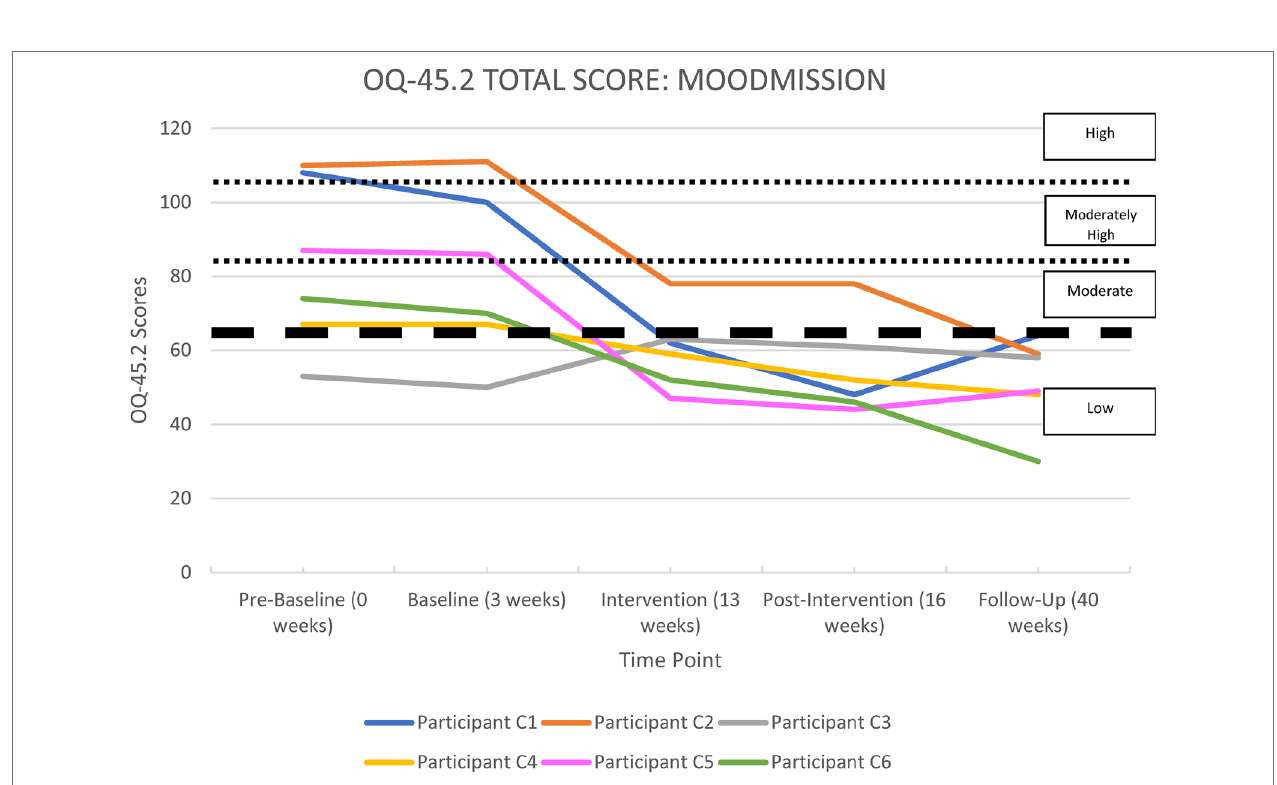
FIGURE 4 | OQ-45.2 total scores for MoodMission .